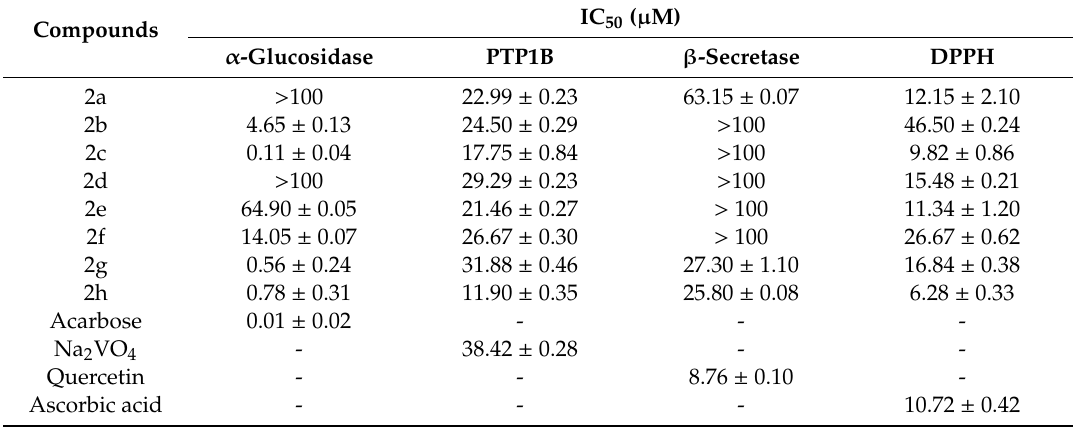
Table 1. PTP1B, α -glucosidase and β -secretase inhibitory activities as well as antioxidant activities